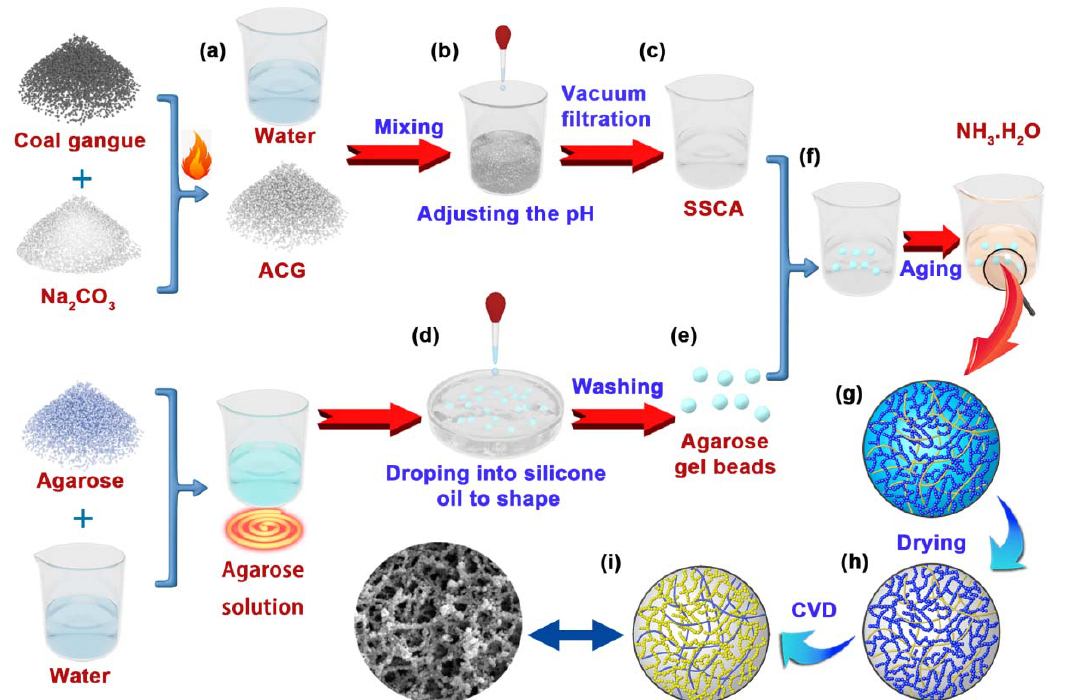
Figure 1. Schematic of the SCAB preparation process. ( a ) Activated coal gangue (ACG) is prepared by calcining a mixture of coal gangue and Na 2 CO 3 , then adding deionized water. ( b ) The pH of the suspension is adjusted. ( c ) SiO 2 sol containing Al 3+ (SSCA) is obtained by vacuum filtration. ( d ) Agarose wet gel beads formed via the agarose (a linear polymer with a long chain alternately linked to 1,3 ‐ linked β‐ D ‐ galactose and 1,4 ‐ linked 3,6 ‐ endoether ‐ L ‐ galactose) solution are dropped into the silicone oil. ( e ) After washing, clean agarose wet gel beads are obtained. ( f ) The agarose wet gel beads are soaked in SSCA. ( g ) After aging and soaking in NH 3 ∙ H 2 O solution, SiO 2 –Al 2 O 3 /agarose composite wet gel beads are obtained. ( h ) The wet gel beads are supercritically dried to obtain SCABs. ( i ) Hydrophobic SCABs are obtained via CVD process.